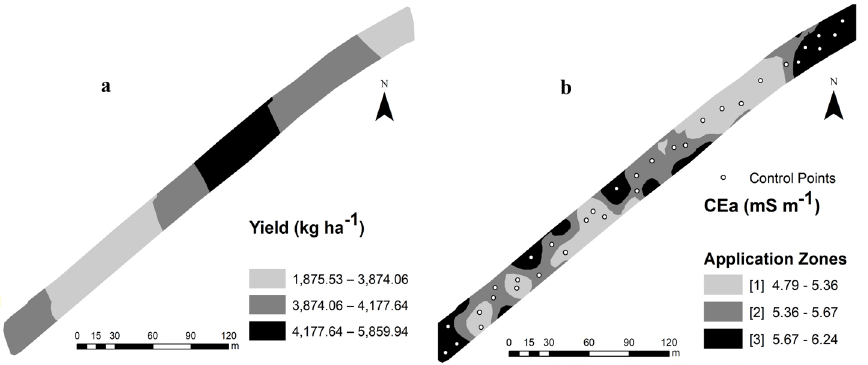
Figure 2. Spatial distribution of soil apparent electrical conductivity (a) based on a regular quadratic grid of 10x10 m, VRT seeding prescription map (b), and sampling points of response variables control in the three management